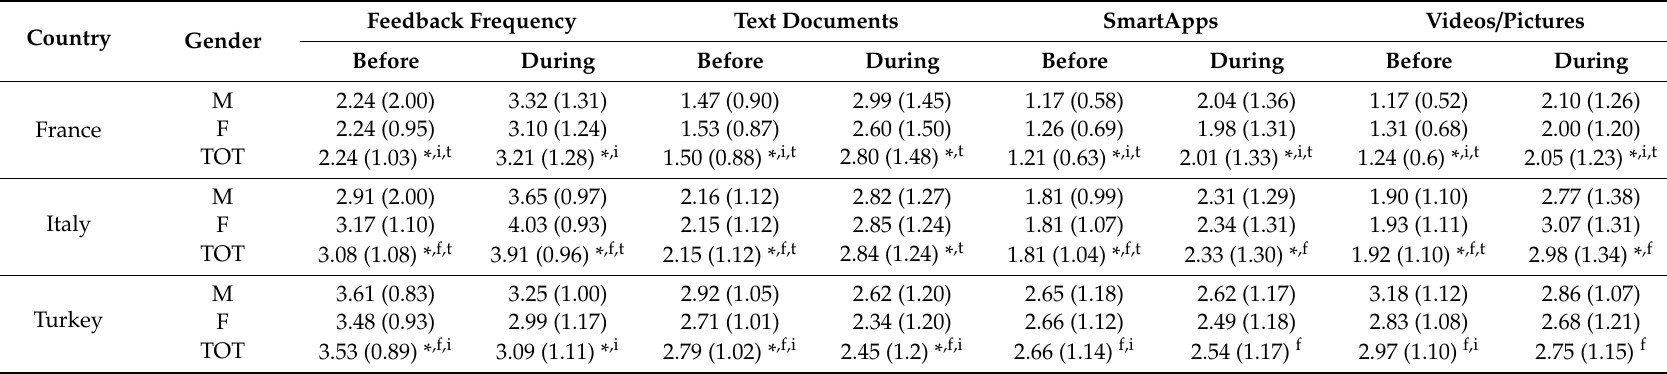
Table 4. Descriptive statistic and Bonferroni post-hoc pairwise comparisons of the interaction time × country in feedback frequency and its di ff erent formats. Country Before Before During Before During Before During